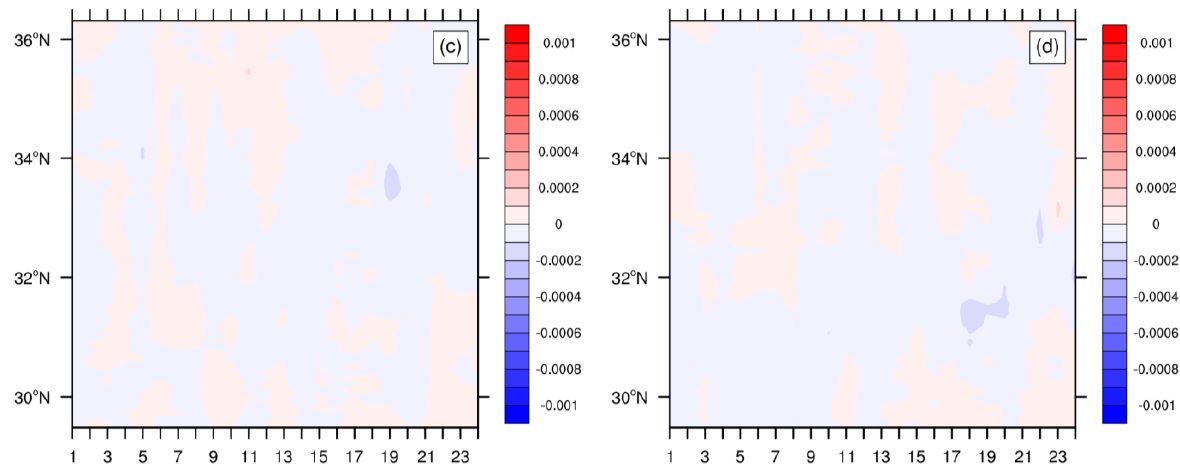
Figure 10. Diurnal-latitude diagrams, where diurnal-latitude diagrams of water vapor mixing ratio (kg kg −1 ) at 500 hPa averaged in domain 3 in CTRL ( a ). Panels ( b – d ) are the differences ( b ) between LowQD and CTRL (LowQD minus CTRL), ( c ) between LowQ and CTRL (LowQ minus CTRL), as well as ( d ) between LowD and CTRL (LowD minus CTRL), respectively. Blue (red) shading indicates negative (positive) variation.